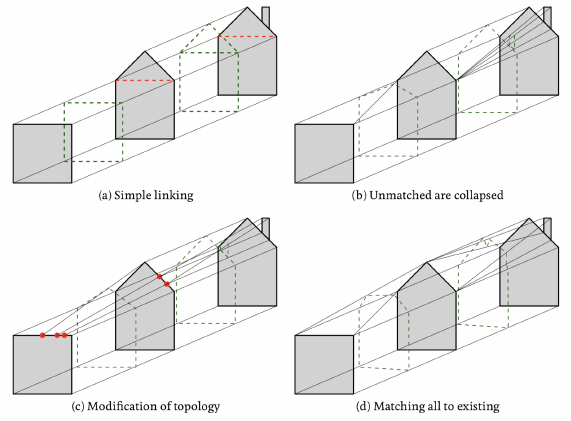
Figure 2. A schematic depiction of the four proposed methods for the linking between corresponding features across two objects (Arroyo Ohori et al.,